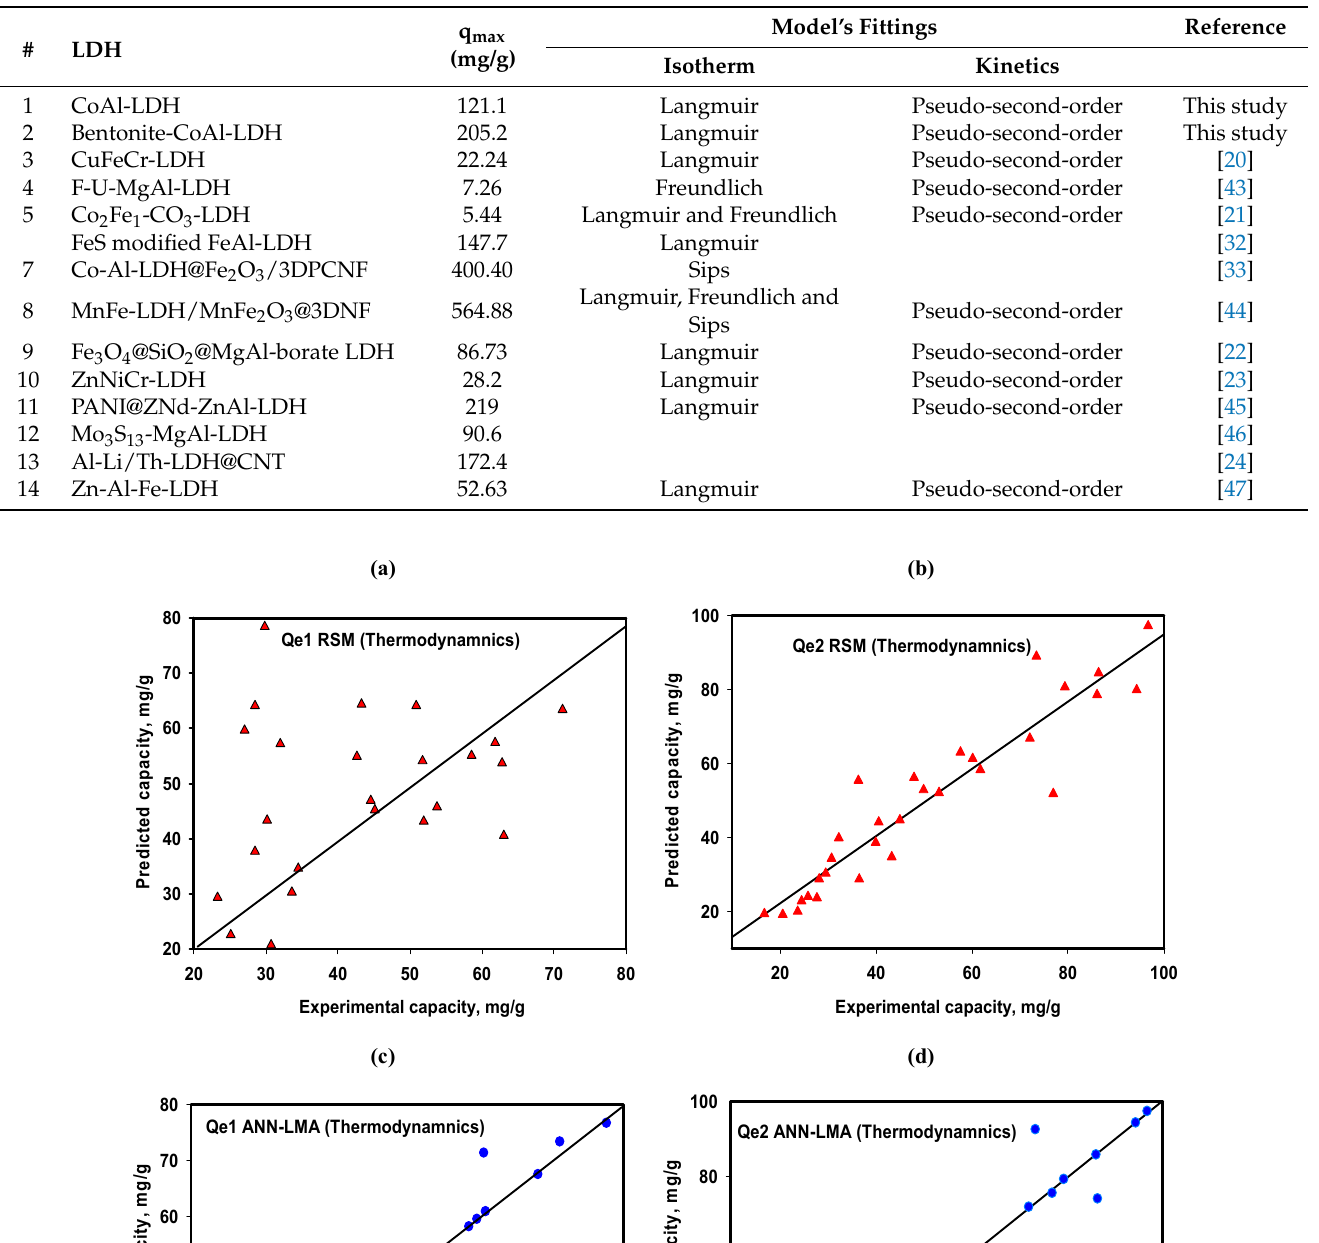
Table 7. Comparison of CoAl-LDH and its bentonite-CoAl-LDH uptake capacities with other LDH- based adsorbents for Cr(VI) uptake.